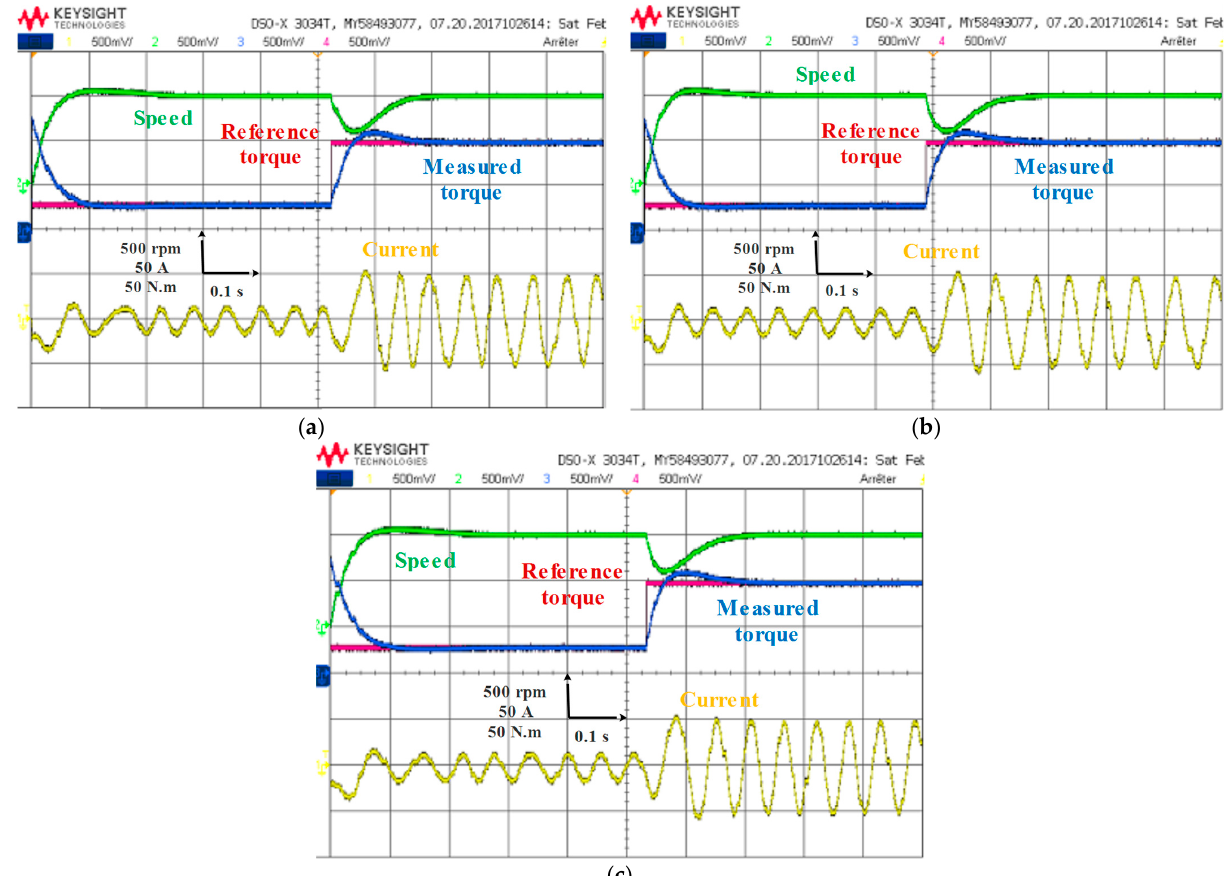
Figure 27. Results of load variation tests with different techniques ( a ) DTC; ( b ) FDTC; ( c )